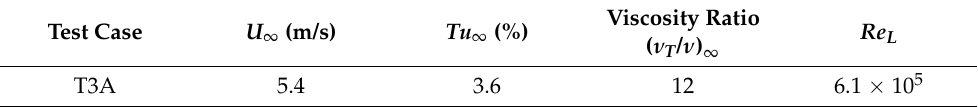
Figure 2. Mesh distribution displayed at every fifth line. Table 1. Flow condition of T3A.